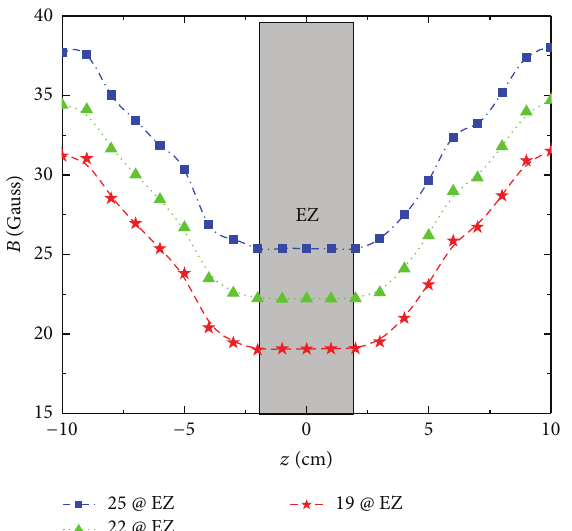
Figure 2: Axial magnetic field distributions measured along the 𝑧 - axis direction; EZ is the exposure zone.